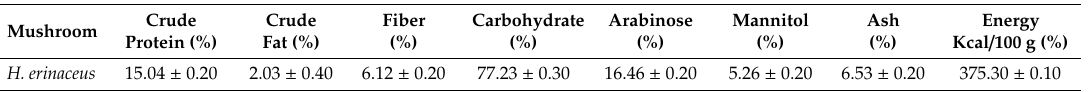
Table 3. Proximate composition (g / 100 g dw), free sugars, and fatty acids in H. erinaceus . Crude Crude Fiber Mushroom Protein (%) Fat (%) (%)